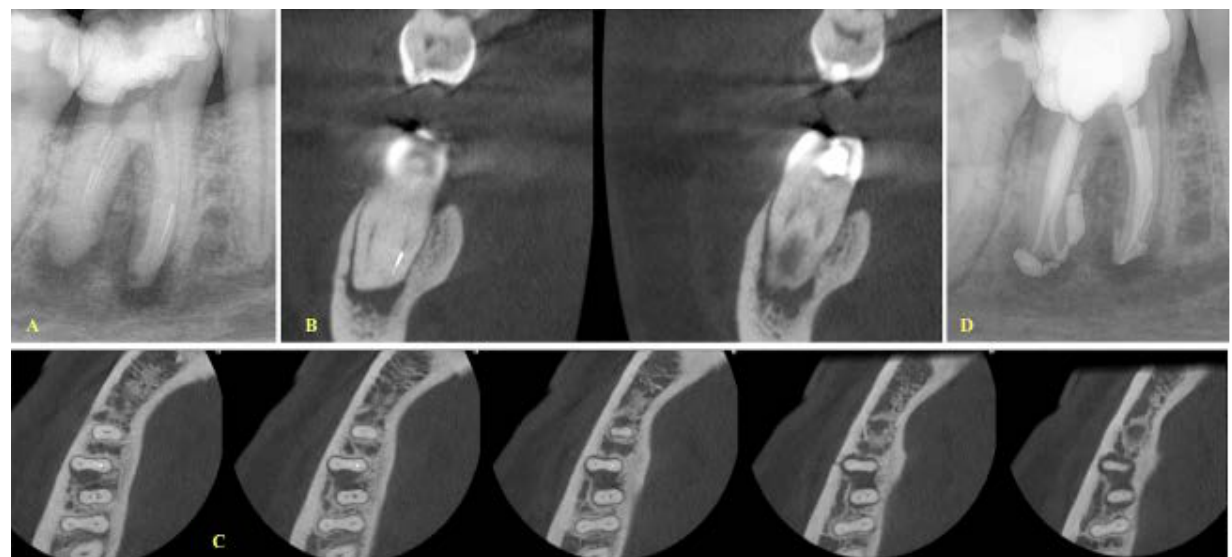
Figure 1. ( A ) Initial radiograph (mesial angle view) of a mandibular first molar with periapical lesions and a fragment at the apical third of the mesial root. ( B , C ). Coronal and axial views demonstrating that the two canals are separate, and the fragment is located in the mesiolingual canal, ( D ) A treatment plan decision to bypass the fragment was made due to the presence of a large lesion, especially at the lingual aspect of the cortical bone. Final radiograph of the case where the bypass of the fragment is